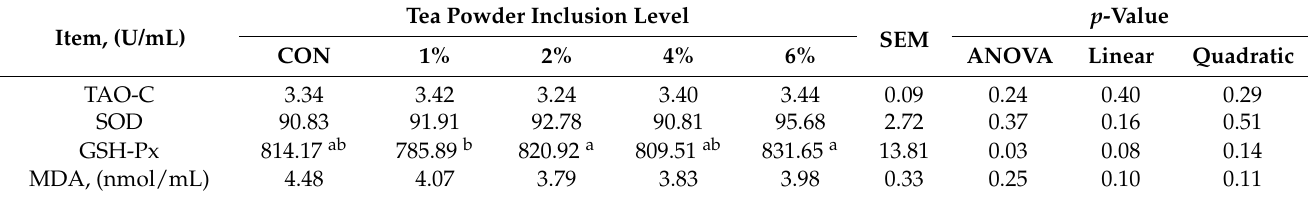
Table 10. Effects of dietary supplements with tea powder on serum antioxidative parameters of the